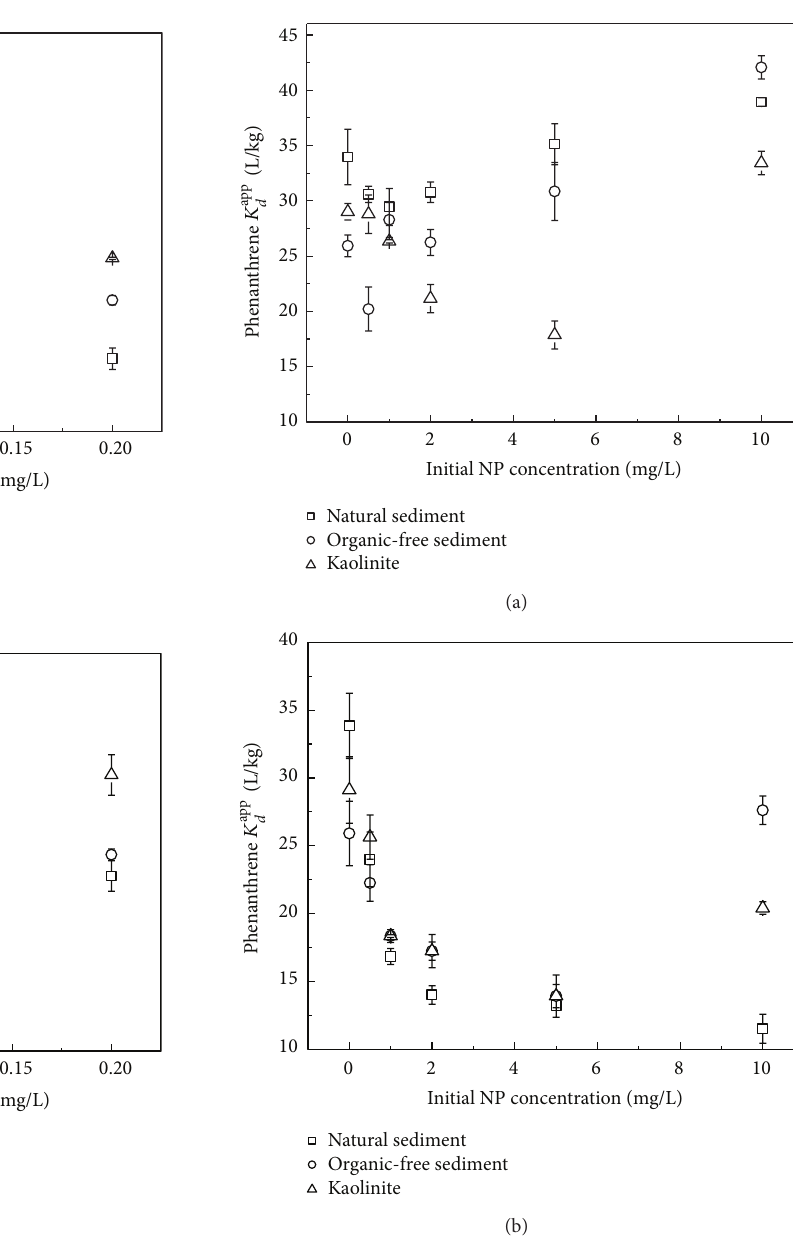
Figure 4: Effect of NP on phenanthrene 𝐾 𝑑 app (a) Group 1; (b) Group